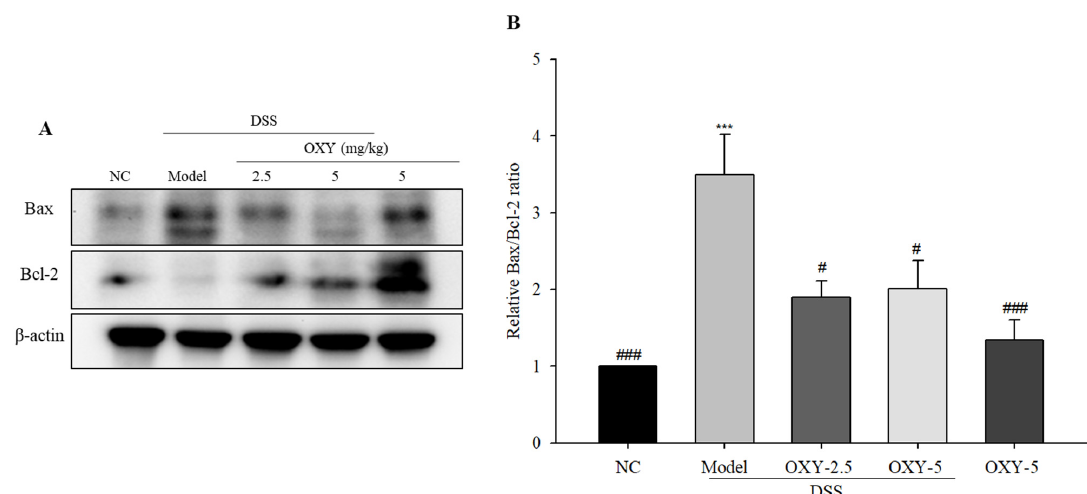
Figure 7. Effect of OXY on the protein expression of Bax/Bcl-2 ( n = 8/group). Bax and Bcl-2 protein expression was determined via western blot ( A ) and quantified ( B ). NC, normal control group; model, DSS-induced colitis model group; DSS + OXY-2.5, DSS-induced colitis rats treated with OXY (2.5 mg/kg) group; DSS + OXY-5, DSS-induced colitis rats treated with OXY (5 mg/kg) group; OXY-5, rats treated with OXY (5 mg/kg) alone group. The values are expressed as mean ± SEM. Significant differences among groups were evaluated via ANOVA with Tukey’s post hoc HSD. *** p < 0.001 compared with the NC group; # p < 0.05 and ### p < 0.001 compared with the model group.